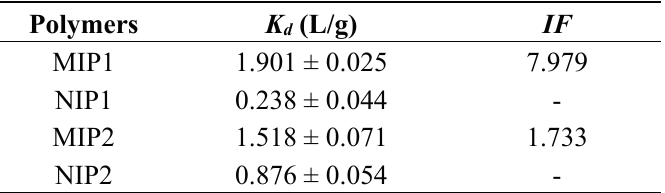
Table 2. Recognition of BzP on the MIPs and NIPs.